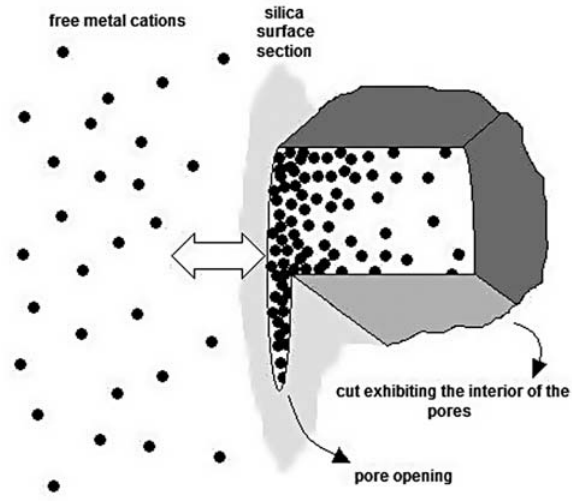
Figure 9. Illustration of a schematic cut of a silica pore (in perspec- tive). The electrostatic repulsion (white arrow) between immobili- zed and free cations (black dots) at the pore’s opening is represen- ted. The cations are predominantly adsorbed at the most external region of the pores, whereas much less metal cations may be coor- dinated by the inner adsorption sites (shown inside the